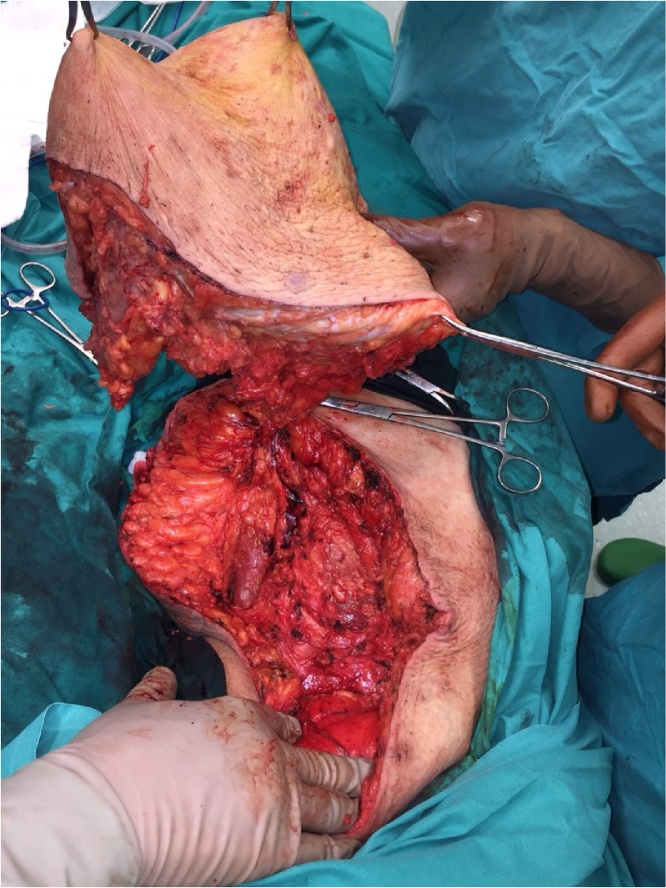
The operative field-meticulous view of the lower anterior mediastinum (a: aberrant mediastinal adenoma/ b: pericardiac sac).